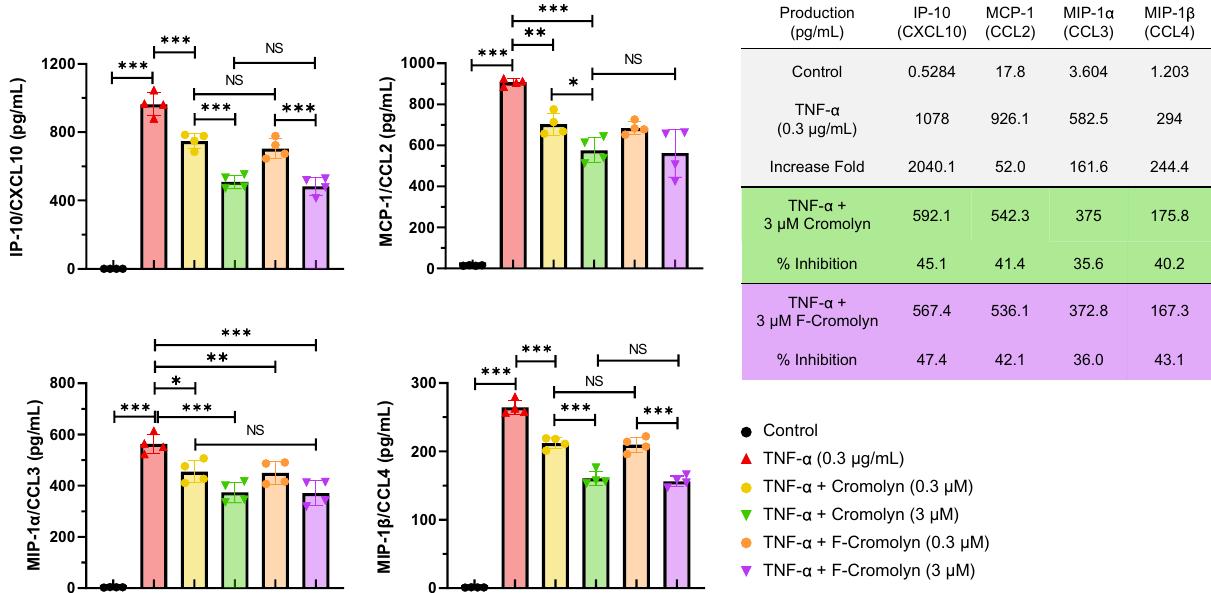
Figure 4. Cromolyn and F-Cromolyn inhibit the secretion of inflammatory chemokines induced by TNF-α in HMC3 microglia cell line. Quantitative analyses of MSD assays indicate the dramatically increased secretion of IP-10 (CXCL10), MCP-1 (CCL2), MIP-1α (CCL3) and MIP-1β (CCL4) from HMC3 cells treated with TNF α (0.3 µg/mL, 24 h), which are subsequently reduced by cromolyn and F-cromolyn (0.3 µM and 3 µM, each). * p < 0.05, ** p < 0.01, *** p < 0.001, and NS (no significant